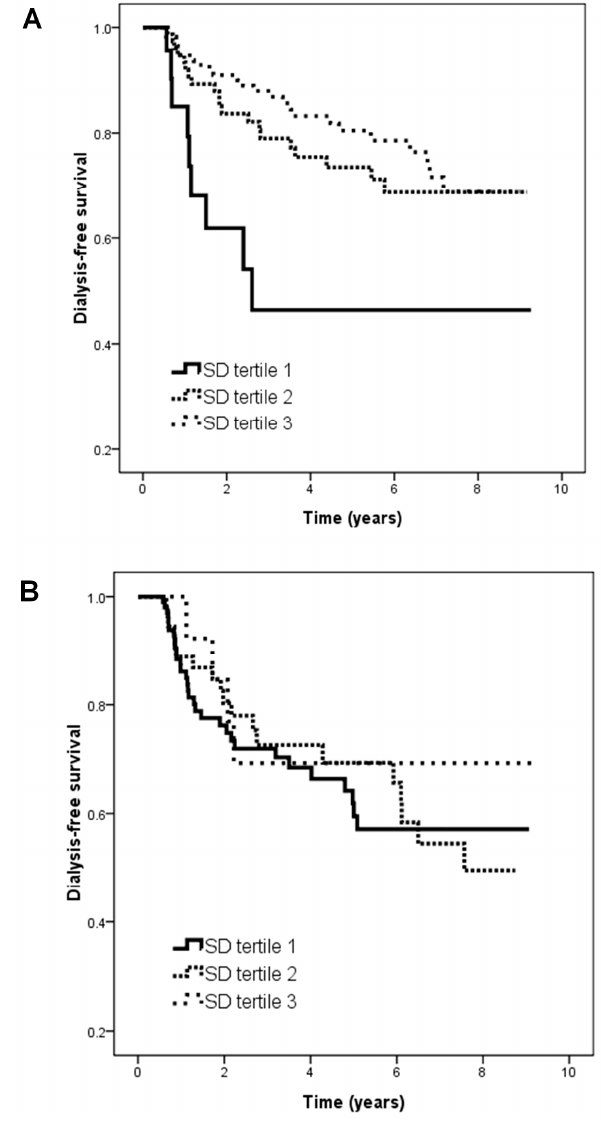
Figure 2. Kaplan–Meier analysis of dialysis-free survival according to tertiles of HbA 1C SD among subjects with ( A ) HbA 1C ≧ 7% (log-rank p = 0.004) and ( B ) HbA 1C < 7% (log-rank p = 0.902).